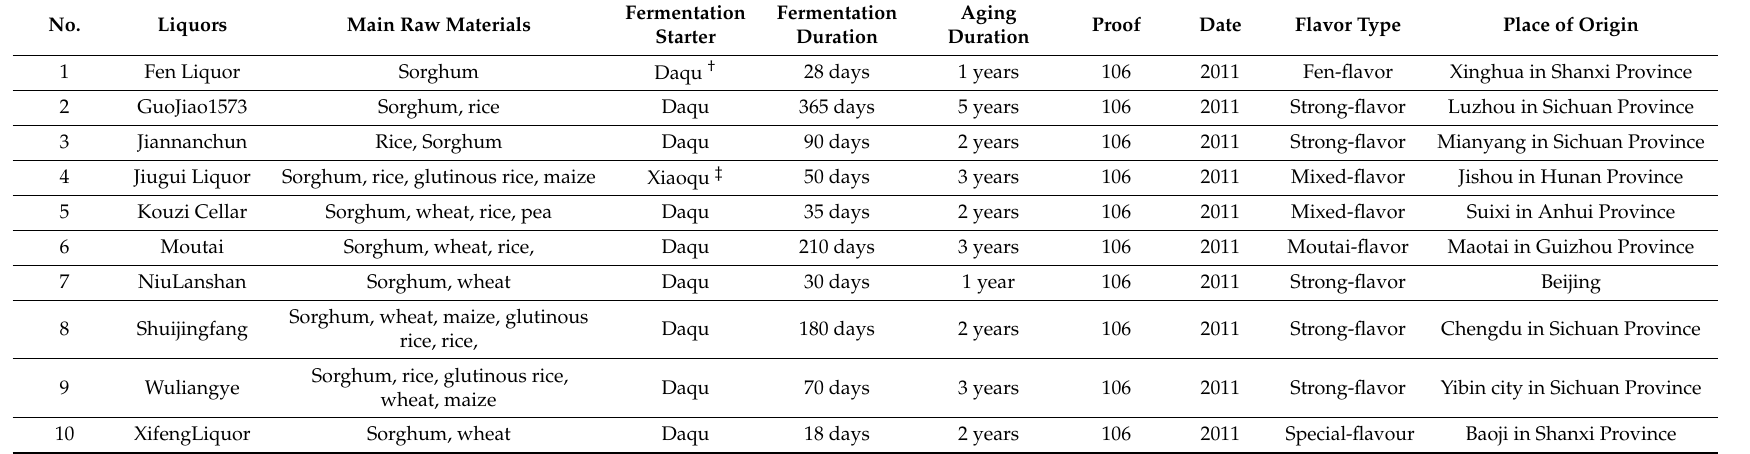
Table 1. Details of the Chinese liquors used in our